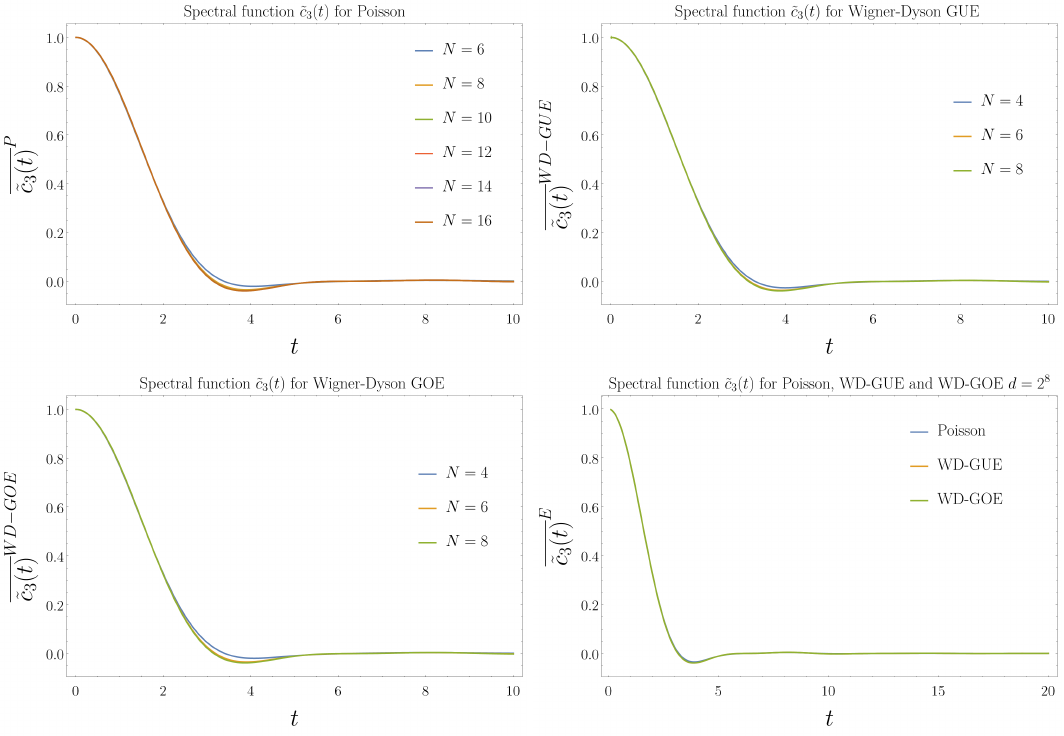
( t ) for Poisson and different system size Figure 18: Top-Left : Log Log plot of ˜ c 3 d = 2 N , N = 4,...,16. Starting from 1, it reaches the asymptotic value 1 / d in a time O ( 1 ) , after a negative dip reached in a time O ( 1 ) . Top-Right : Log Log plot of Wigner-Dyson GOE for different system size 2 N , N = 4,6,8. Starting from 1, it goes below the asymptotic value 1 / d in a time O ( 1 ) and reaches the asymptotic value in a time O ( 1 ) . Bottom-Right : Log Log plot of Wigner-Dyson GUE for different system size 2 N , N = 4,6,8.Starting from 1, it reaches the asymptotic value 1 / d in a time O ( 1 ) , after a negative dip reached in a time O ( 1 ) . Bottom-Left : Comparison between Poisson, Wigner-Dyson from GOE and GUE for d = 2 8